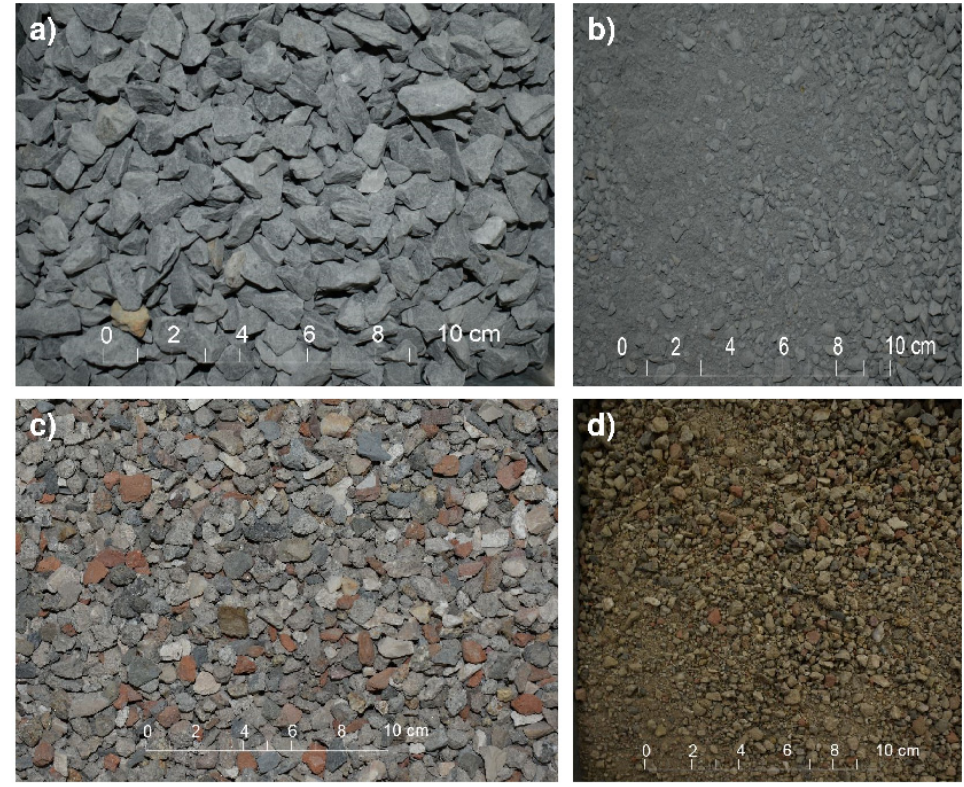
Figure 1. View of the aggregates used to manufacture concretes. Legend: ( a ) View of natural aggregate; ( b ) View of natural aggregate after grinding; ( c ) View of recycled aggregates and ( d ) View of recycled aggregates after grinding.